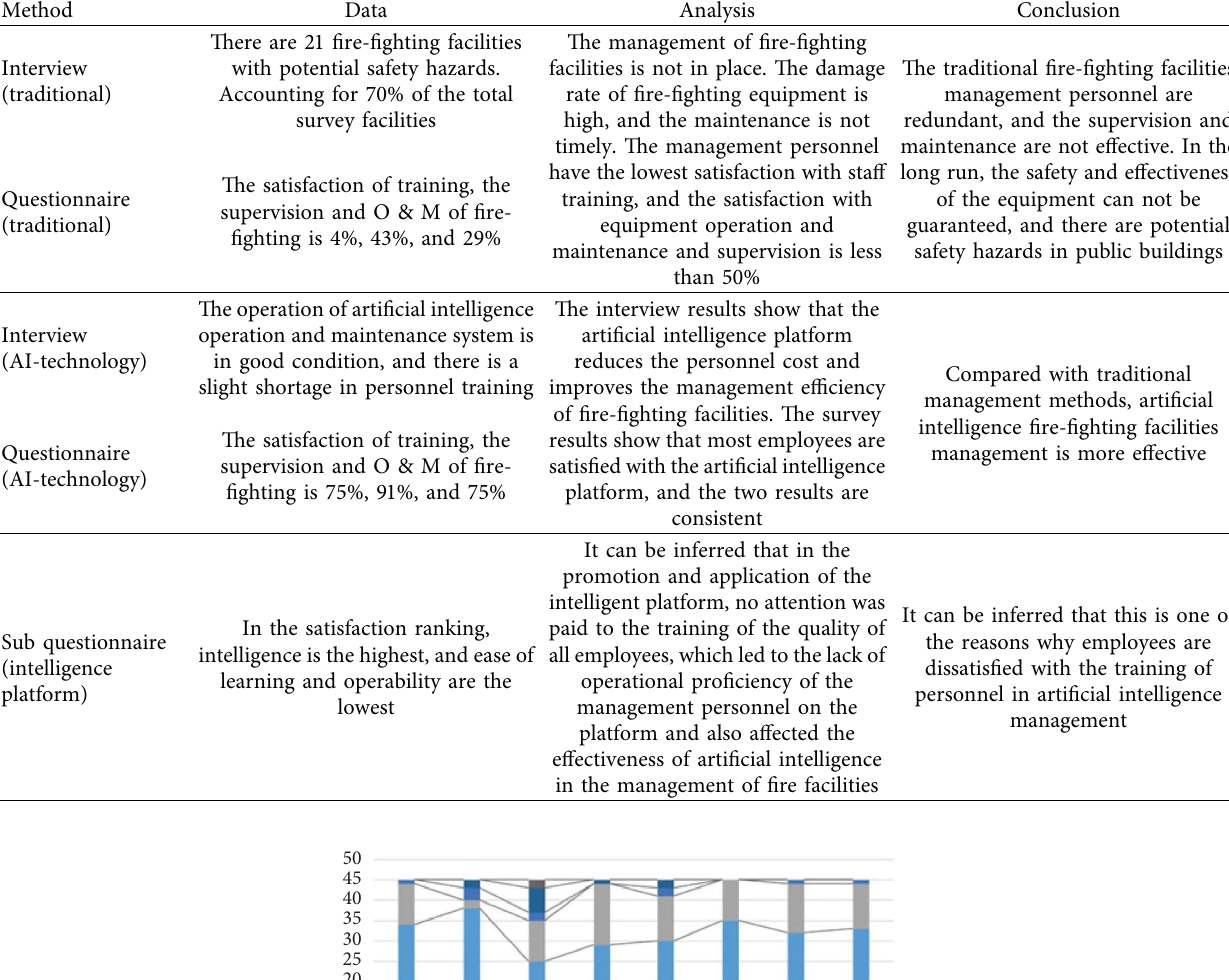
Table 17: Conclusion of the fndings.